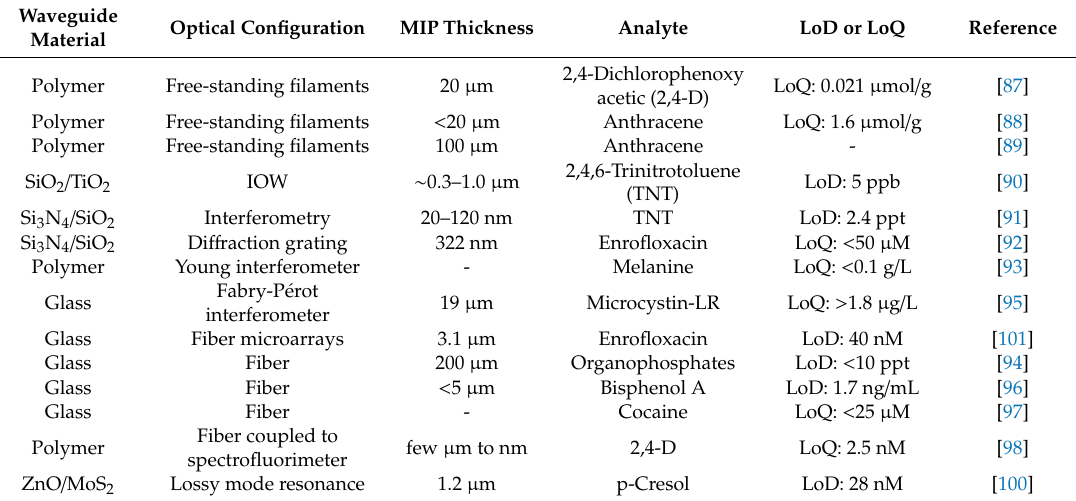
Table 2. MIPs coupled to